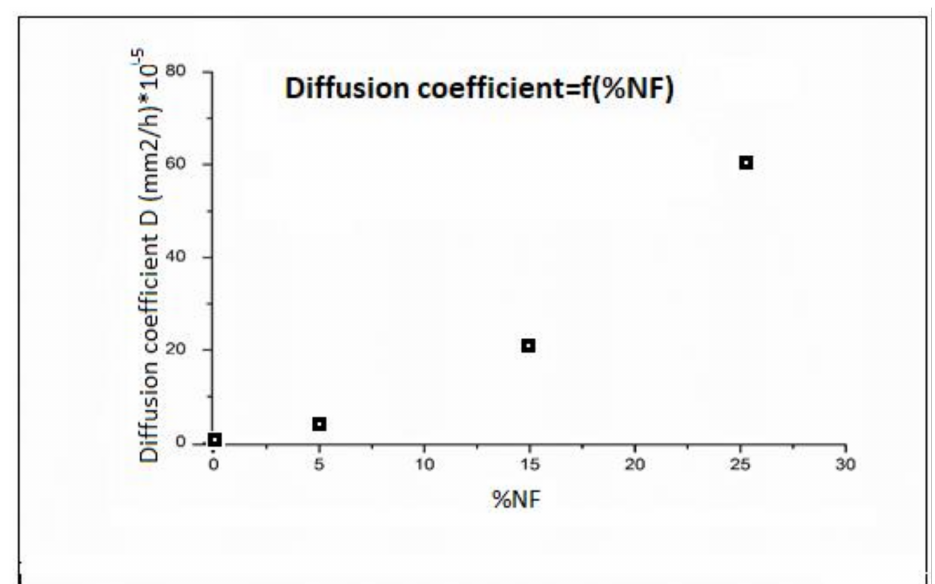
Figure 6. Diffusion coefficient vs. date palm tree fibers volume fraction (%).